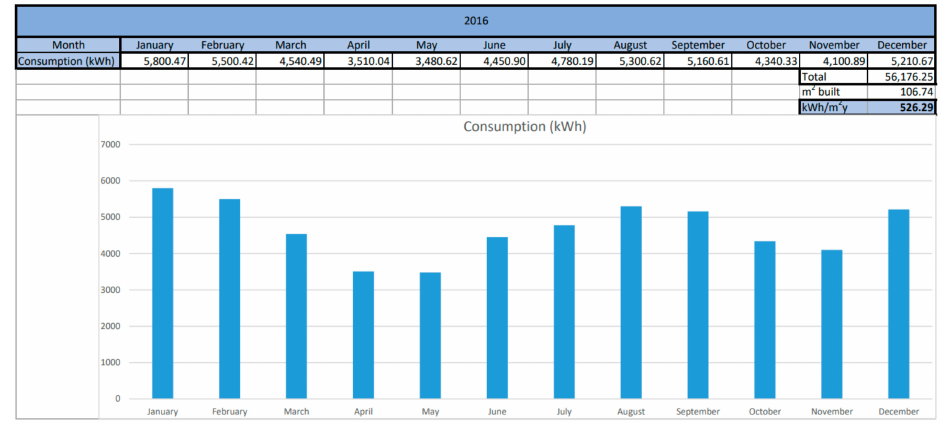
Figure 5. Monthly energy consumption in a whole year (2016) before